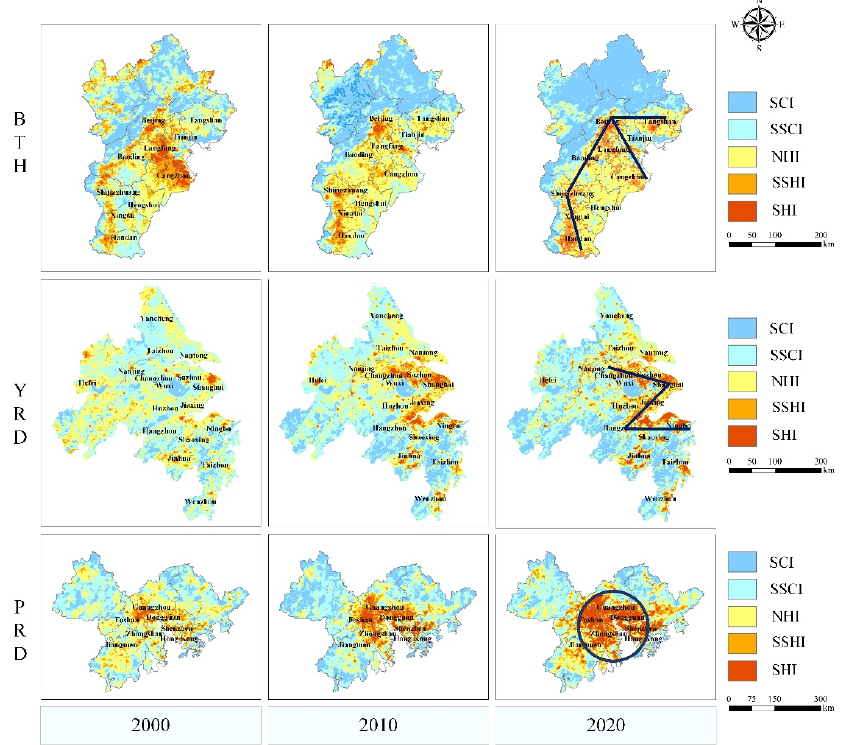
Figure 4. Spatial distribution of different regional heat island intensity levels of each urban agglom- eration. BTH, Beijing–Tianjin–Hebei; YRD, Yangtze River Delta; PRD, Pearl River Delta; SCI, strong cold island; SSCI, sub-strong cold island; NHI, no heat island; SSHI, sub-strong heat island; SHI, strong heat island.